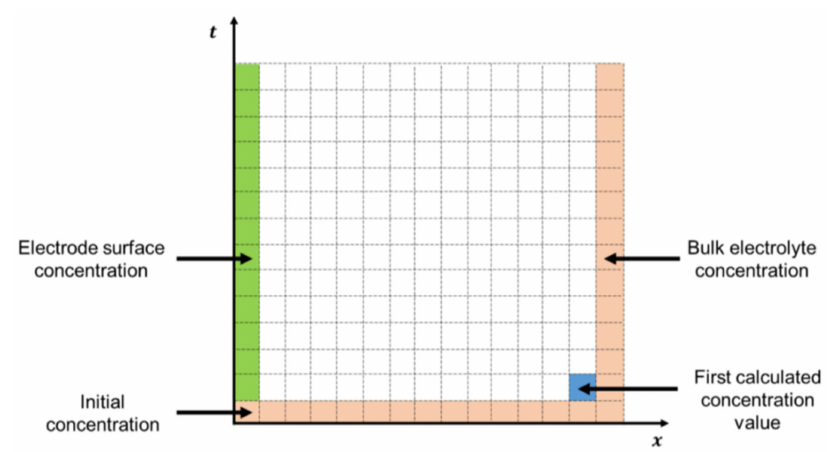
Figure 2. Concentration grid with initial and border